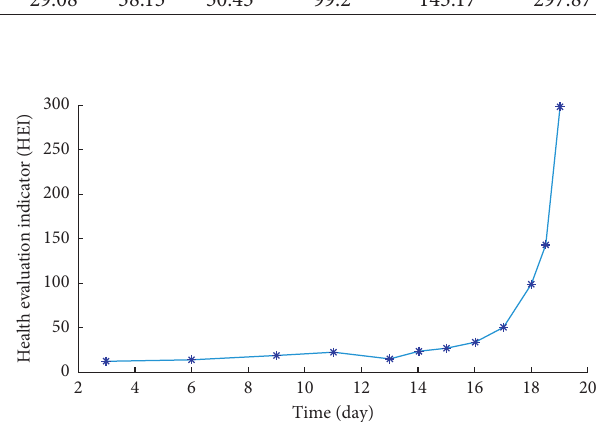
Figure 11: The trend of HEI. ◊ : low-dimensional spatial charac- teristics of health comparison signals after LLE processing; ✫ : low- dimensional spatial characteristics of analysis signals after LLE processing; ■ : the center of low-dimensional characteristics of health comparison signals; ● : the center of low-dimensional characteristics of analysis